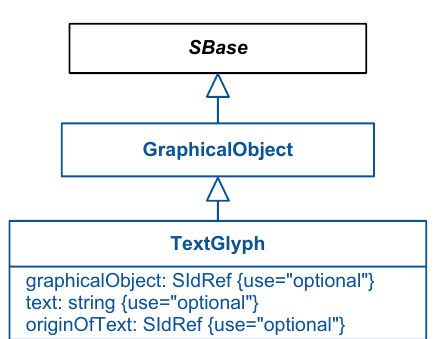
Figure 14: The definitions of the TextGlyph